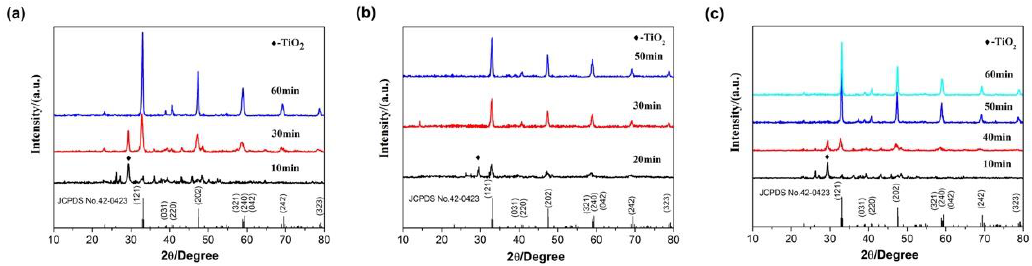
Figure 8. XRD patterns of the Ca 0.97 TiO 3 :Eu 3+0.03 sintered at different microwave sintering power. ( a ) 800 W; ( b ) 680 W; ( c ) 528 W.